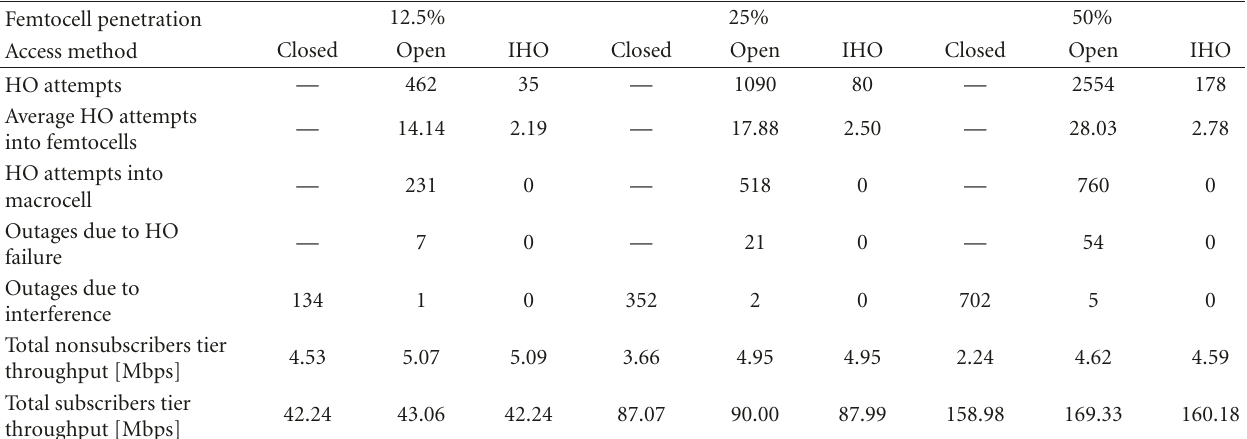
Table 7: Performance comparison for Setup 2 (800 s